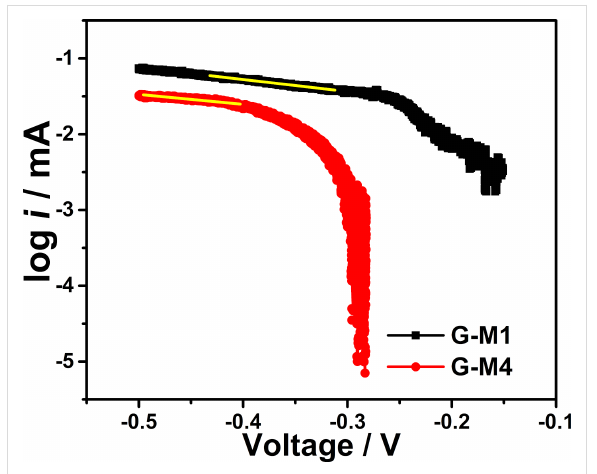
Figure 6: Tafel plots of ORR over EEG-modified electrodes in 0.1 M KOH O 2 -saturated